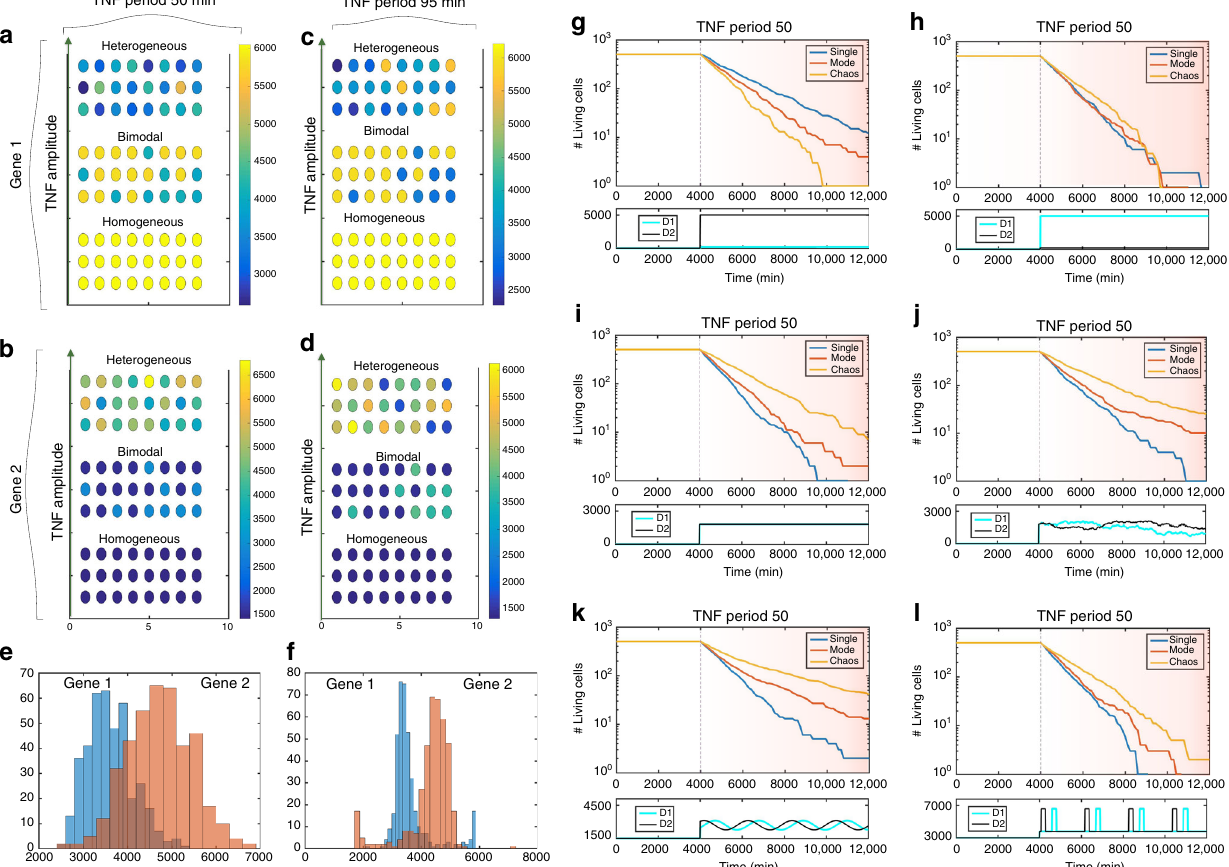
Fig. 4 Population heterogeneity emerges from chaos. a Protein concentration from an HAG with K = 1, h = 2 and external TNF period 50 min. Bottom: The concentration corresponding to a single-mode oscillation; TNF amplitude: 0.04. Middle: The concentration corresponding to mode-hopping; TNF amplitude: 0.12. Top: The concentration corresponding to chaos; TNF amplitude: 0.36. b Protein concentration from an LAG with K = 4.5, h = 4. TNF period 50 min. TNF amplitudes are identical to those used in a . c Protein concentration from the HAG. TNF period 95 min. Bottom: The concentration corresponding to a single-mode oscillation; TNF amplitude: 0.1. Middle: The concentration corresponding to mode-hopping; TNF amplitude: 0.2. Top: The concentration corresponding to chaos; TNF amplitude: 0.4. d Protein concentration from the LAG. TNF period 95 min. TNF amplitudes are identical to those used in c . e Distribution of protein concentrations in the chaotic state (TNF period: 50 min, TNF amplitude: 0.36). f Distribution of protein concentrations in the chaotic state (TNF period: 95 min, TNF amplitude: 0.4). g Number of surviving cells vs. time (drug is added at T = 4000 min). D 1 = 6000, D 2 = 0. h Same as g with D 1 = 0, D 2 = 6000. i Same as g with D 1 = D 2 = 3000. j Same as g with _ D 1 þ 2 ¼ Nð 0 ; 100 : 0 Þ and D 1 + 2 (0) = 3000. The panel below shows a speci fi c trajectory on this pattern. In general D 1 is above D 2 50% of the times and vice versa. k Same as g with (cid:6) (cid:7) (cid:6) (cid:7) ð t Þ ¼ 3000 þ 1500 (cid:4) sin t þ Ω þ Ω D . l Same as g with D 1 + 2 ( t ) = 7000 if sin t > 0 : 95 and otherwise D 1 + 2 ( t ) = 1 þ 2 5000 5000